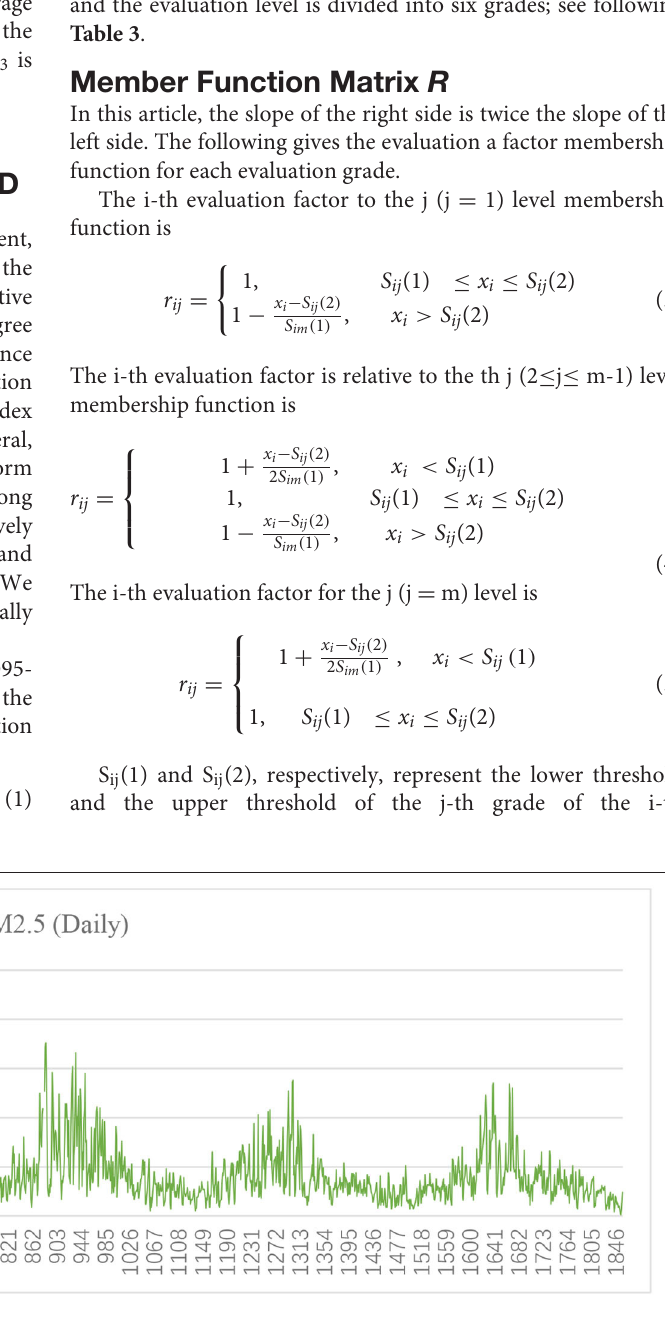
Frontiers in Public Health |